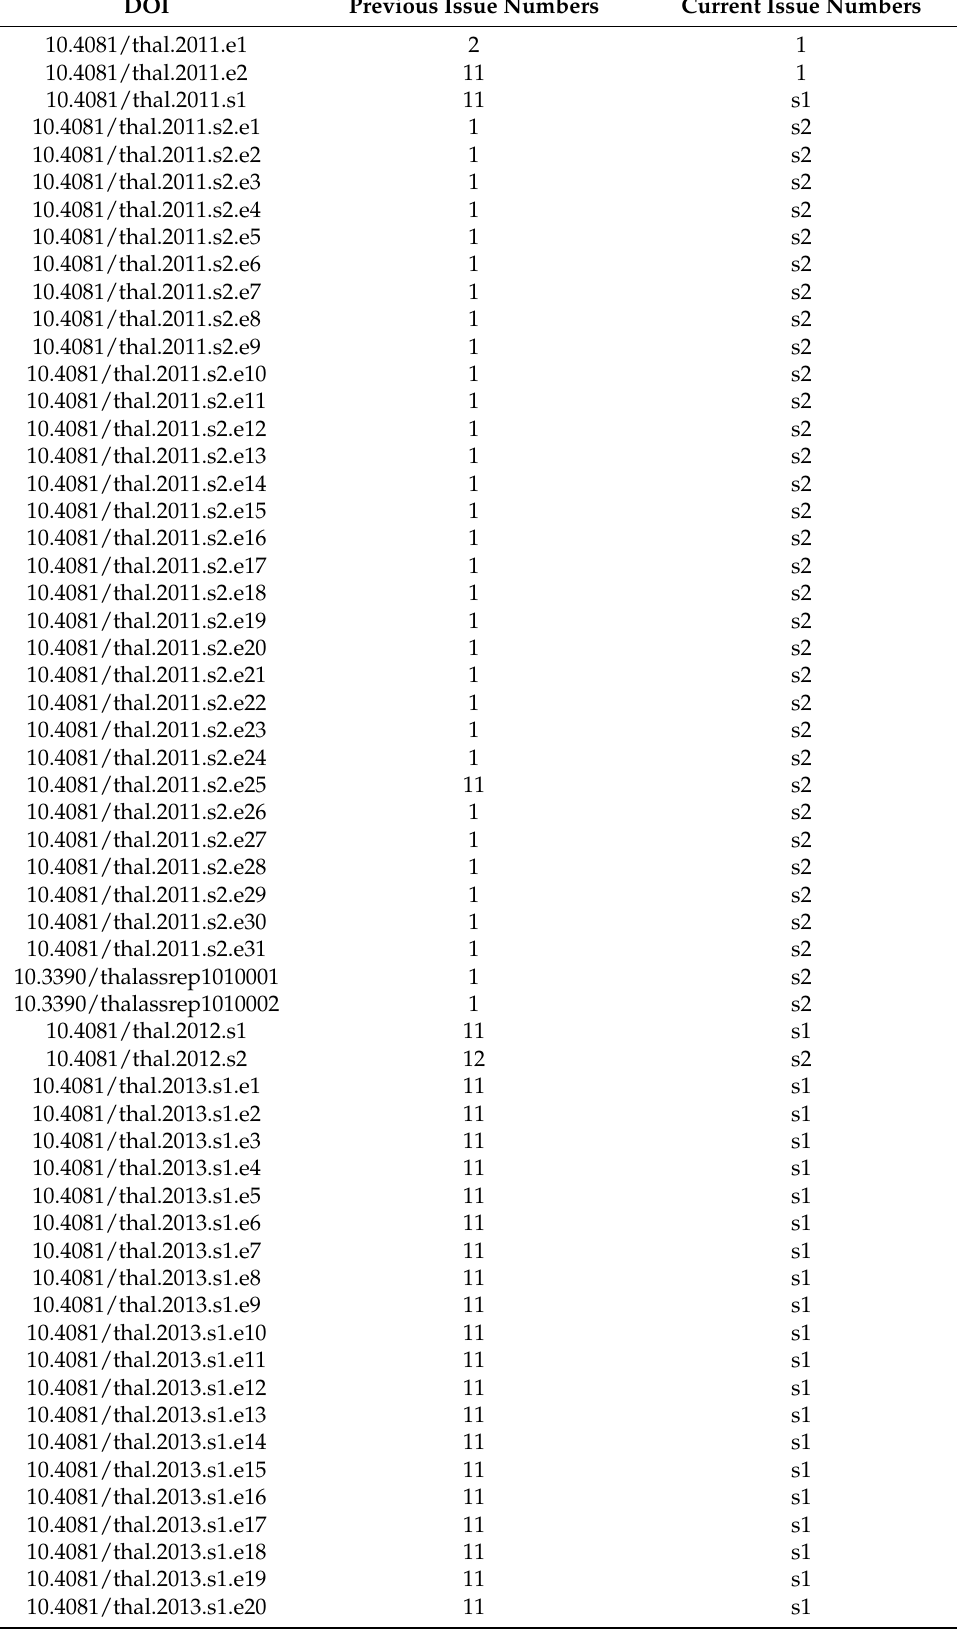
Table 2. Corrected Issue Numbers for 84 articles from Volumes